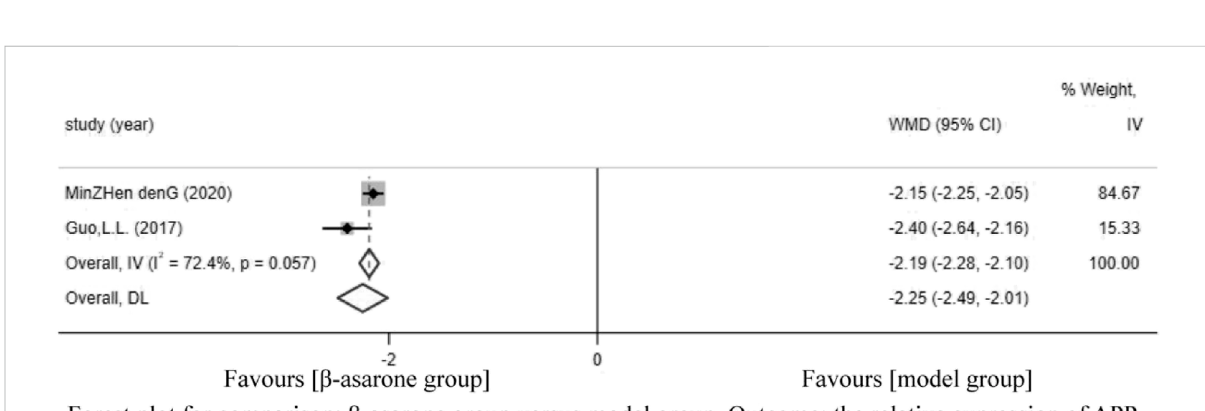
FIGURE 5 Forest plot for comparison: β -asarone group versus model group. Outcome: the relative expression of